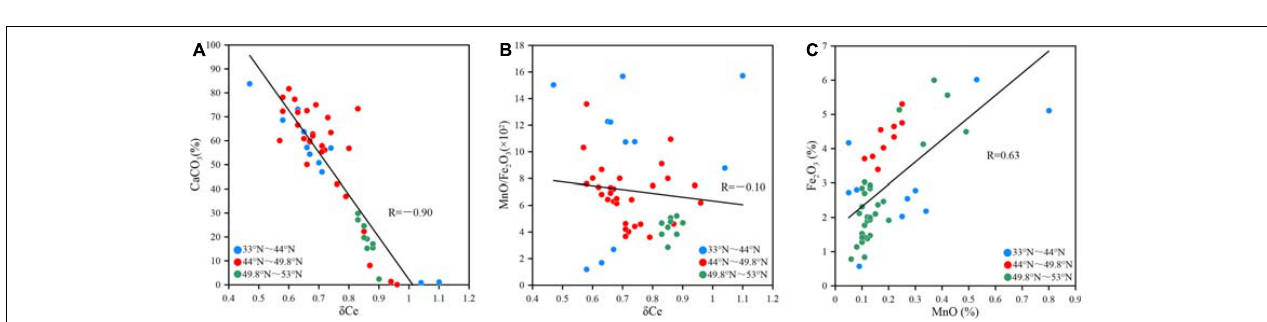
FIGURE 11 | The scatter plots between CaCO 3 and δ Ce (A) and between MnO/Fe 2 O 3 ratio of Fe-Mn phase and δ Ce of bulk sediments (B) and between Fe 2 O 3 and MnO (C)